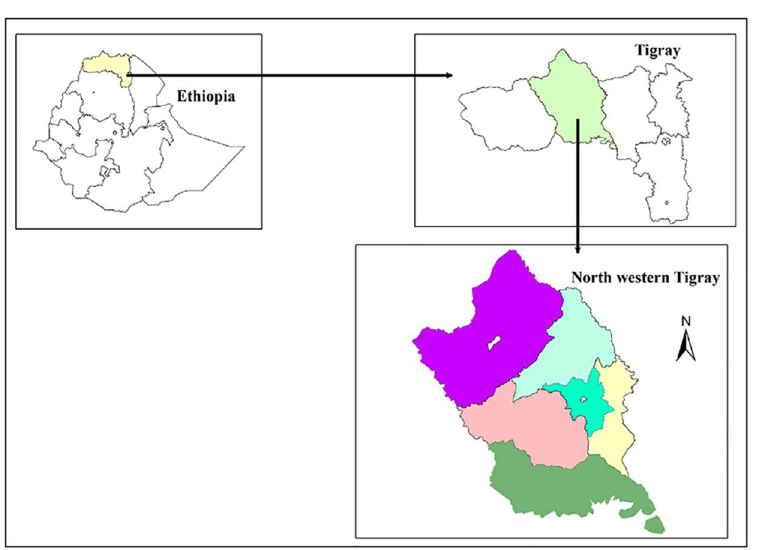
Fig 1. Map of the study